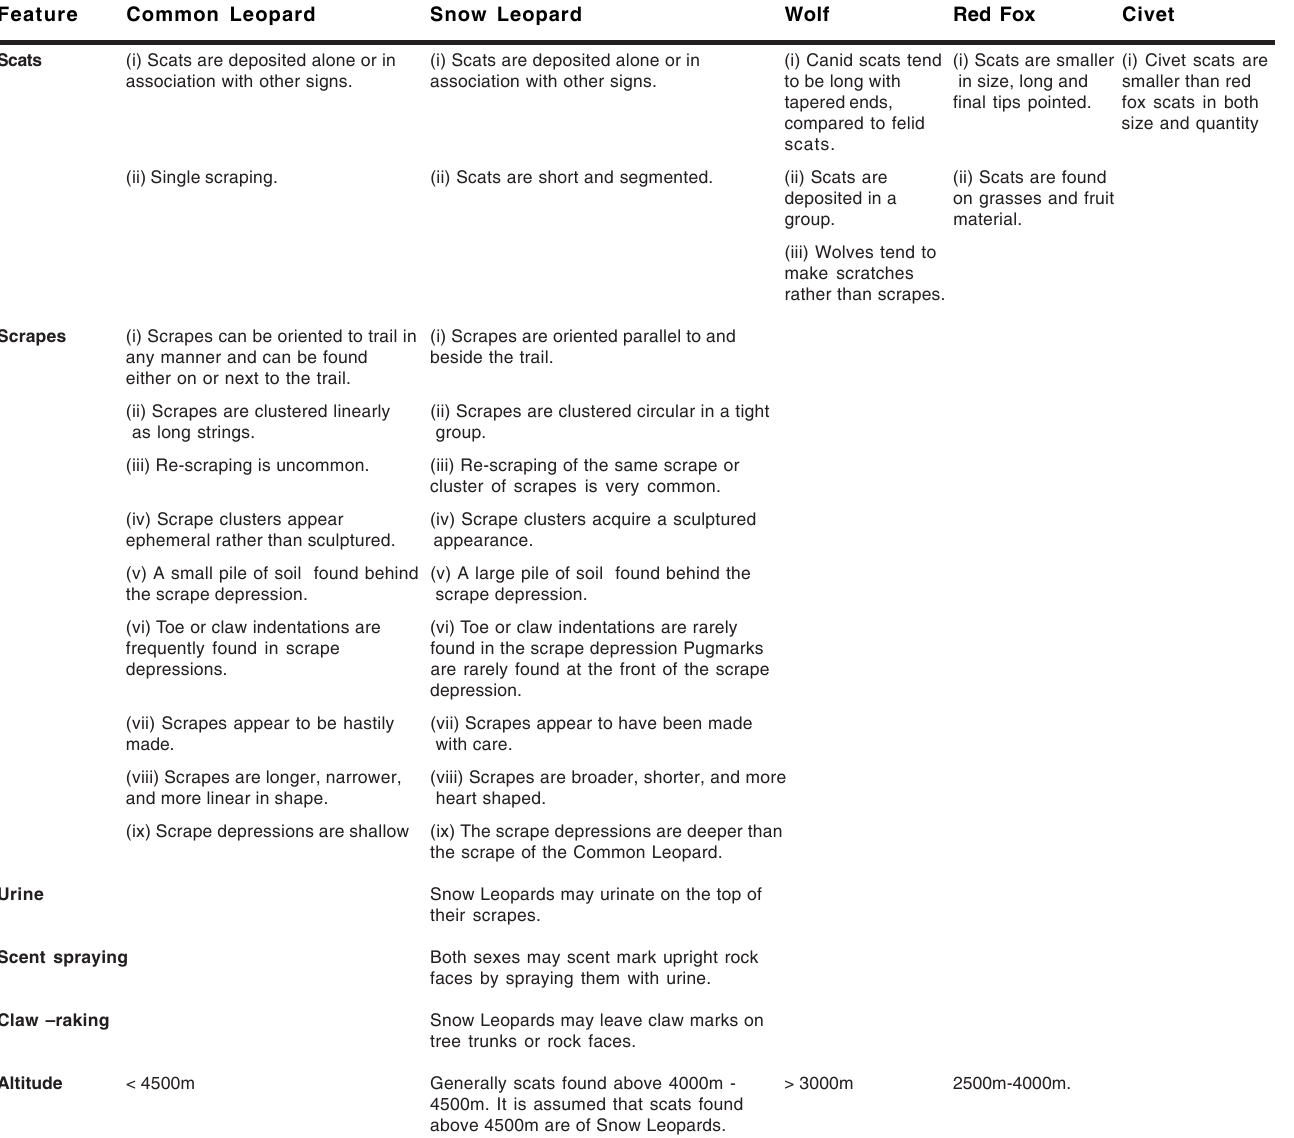
Table 1. The distinguishing characteristics of different predator signs that were used to confirm the presence of various species Scats